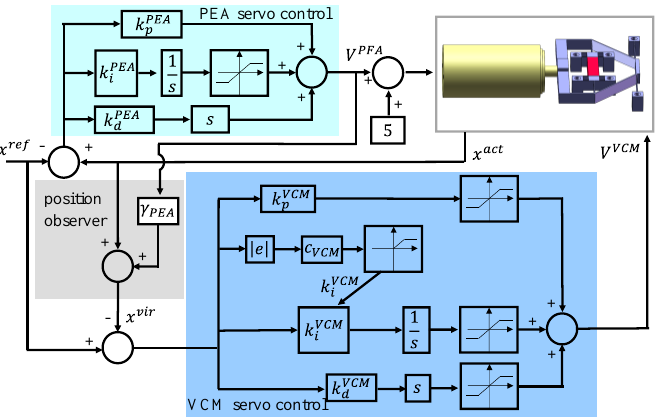
Figure 11. Block diagram of the double-servo cooperative control (DSCC) strategy.